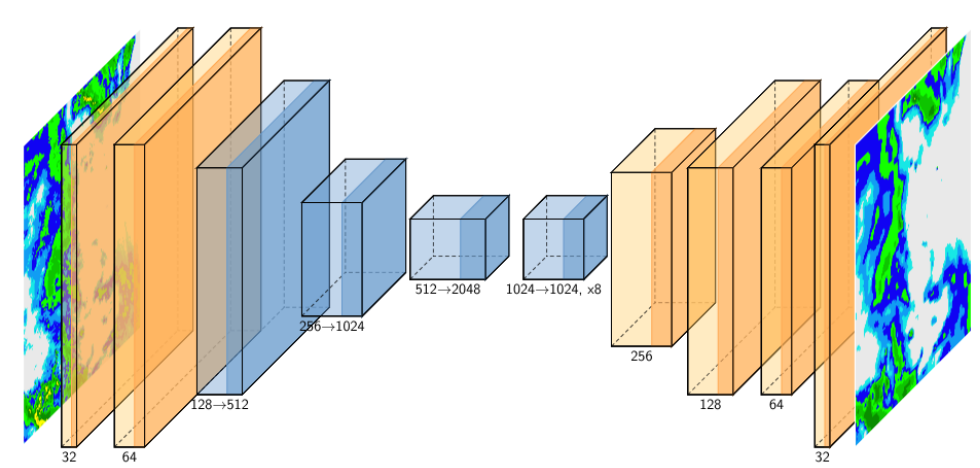
Figure 3. The proposed NeXtNow architecture. The ResNeXt blocks are depicted in blue, while classical convolutional layers are shown in orange. In the case of the ResNeXt blocks, the filters that correspond to the first and last convolutions in the block are shown, while only only the number of filters is shown for the plain convolutions. This figure was created using the PlotNeuralNet package